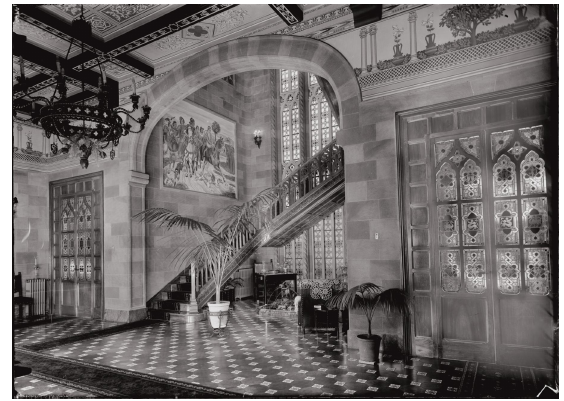
Figure 7 . Interior details of Villa Rutelli.